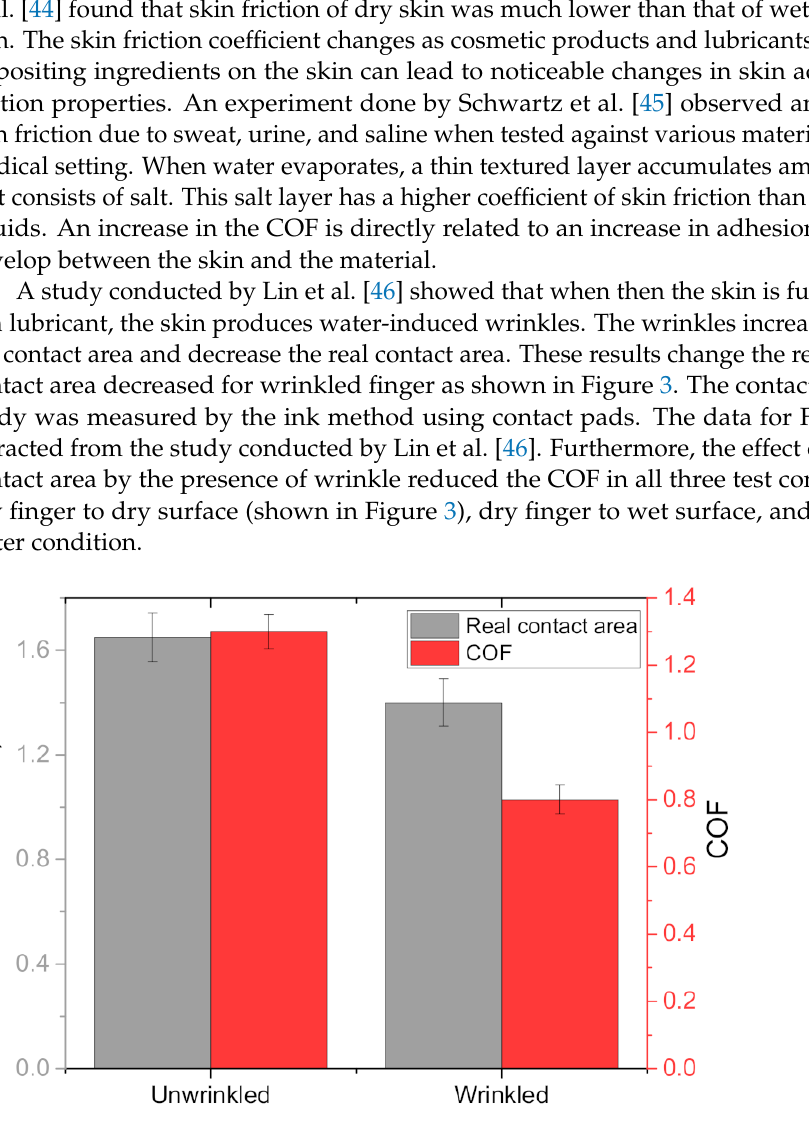
Figure 3. The effect of wrinkles on the real contact area and COF against dry PET flat surface at 2 N normal